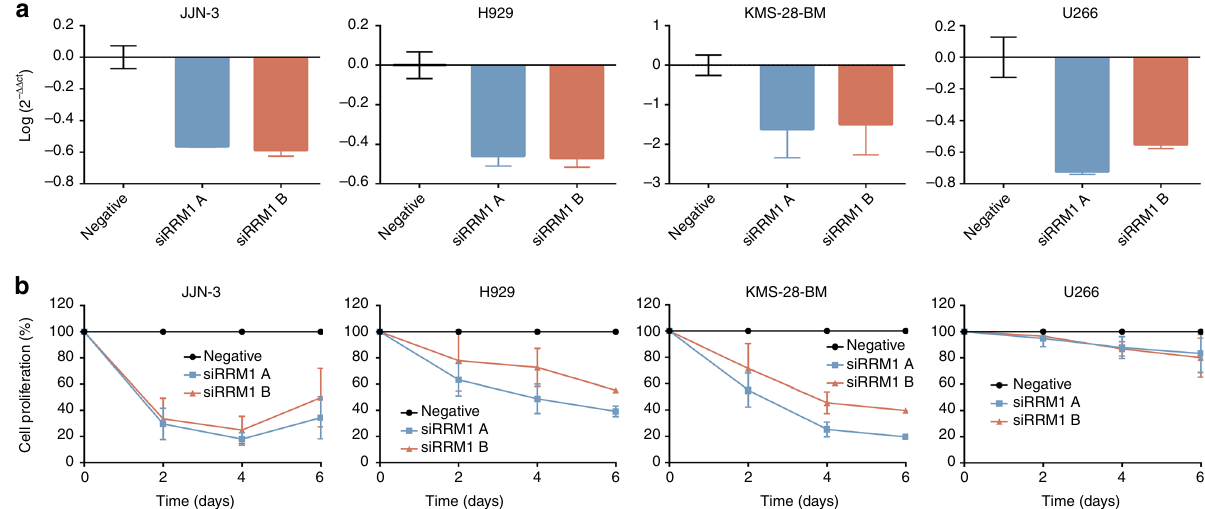
Fig. 3 Gene silencing analysis of RRM1 in JJN-3, H929, KMS-28-BM and U266 MM cell lines. a mRNA expression of RRM1 gene 48 h after nucleofection with the speci fi c siRNAs. Data are referred to GUS gene and an experimental group nucleofected with negative control siRNA. b Proliferation of JJN-3, H929, KMS-28-BM and U266 cell lines nucleofected with siRNAs targeted to RRM1 gene was studied by MTS. The proliferation percentage refers to cells nucleofected with a negative control siRNA. Data represent mean ± standard deviation of at least three